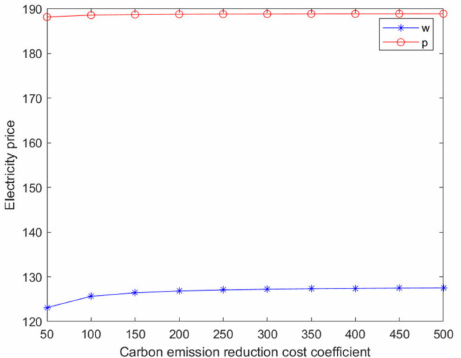
Figure 4. The impact of the carbon emission reduction cost coefficient on the ex-factory electricity price and the market electricity price under the condition of decentralized decision making in the supply